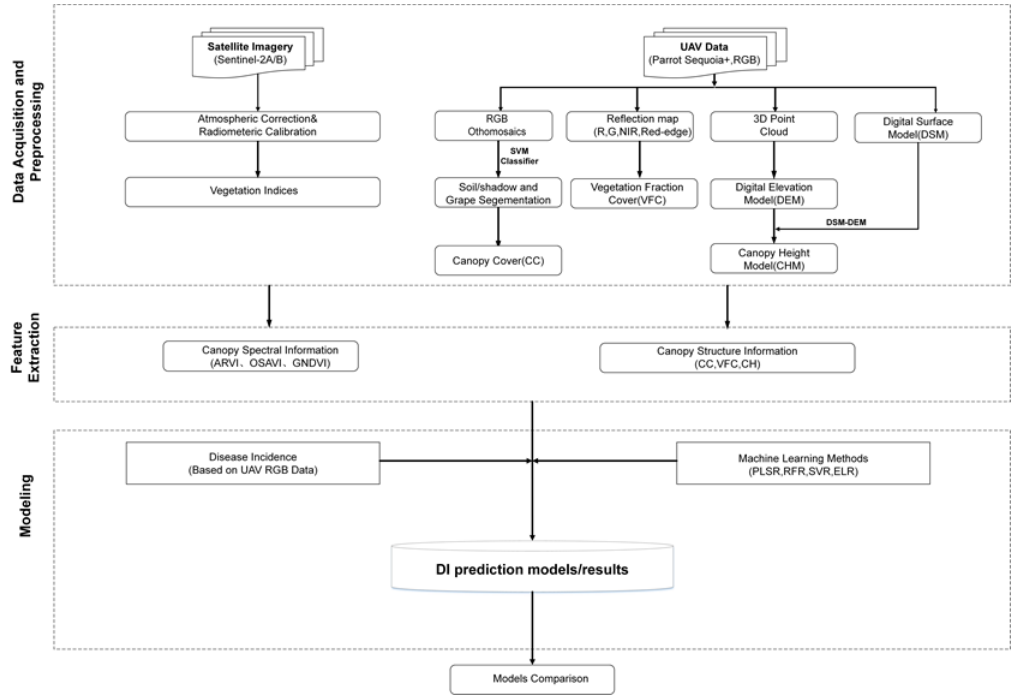
Figure 3. A workflow chart including data preprocessing, feature extraction, machine learning modeling, and analysis.